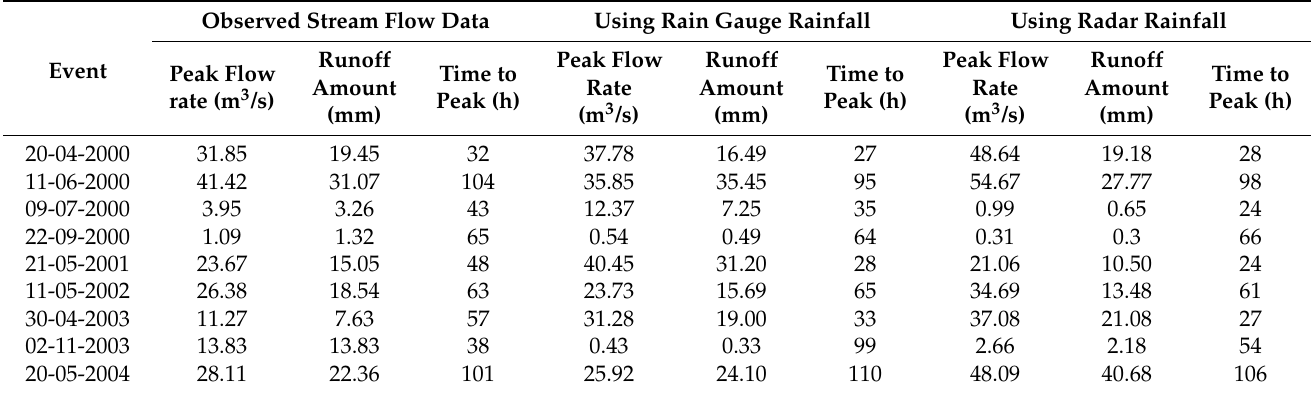
Table 6. Summary of observed and simulated peak flow rate, runoff amount, and time to peak obtained using best estimated Green and Ampt model parameters with rain gauge and radar rain- fall inputs.